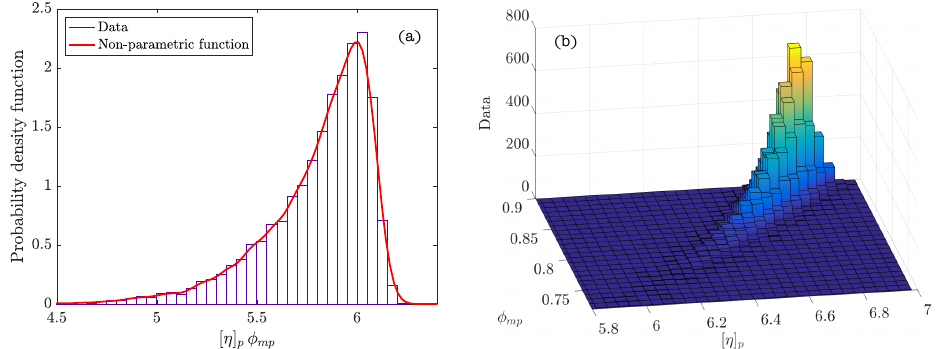
Figure 6. ( a ) Density function of probability of the product of parameters φ m p [ η ] p (exponent of the Krieger–Dougherty equation); ( b ) bivariate histogram of φ m p and [ η ] p